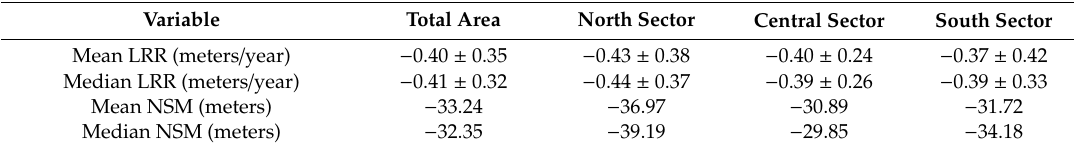
Table 2. Evolution rates LRR (linear regression) and NSM (net shoreline movement) between 1956 and 2017.